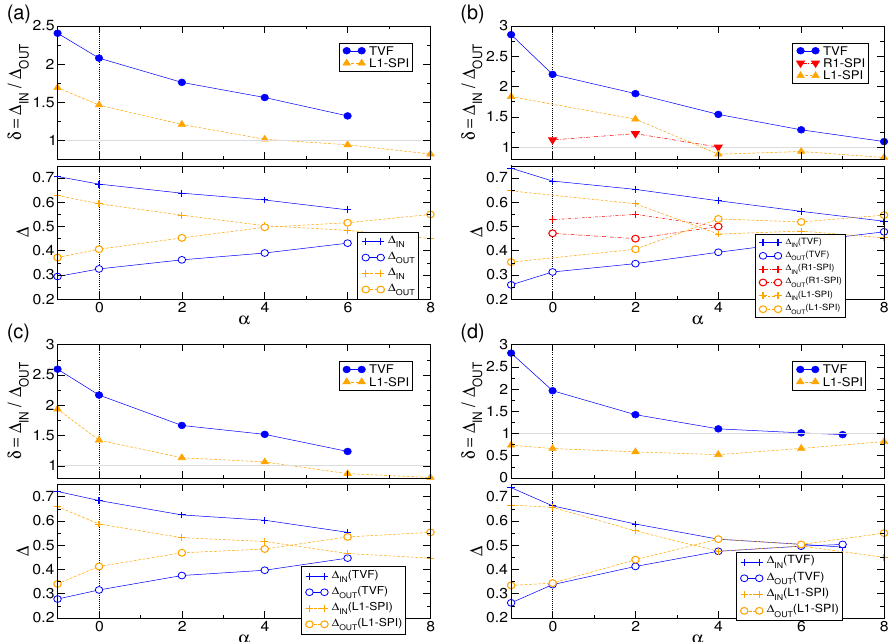
∆ IN ∆ (see Figure 5) for various vortex structures versus α for OUT